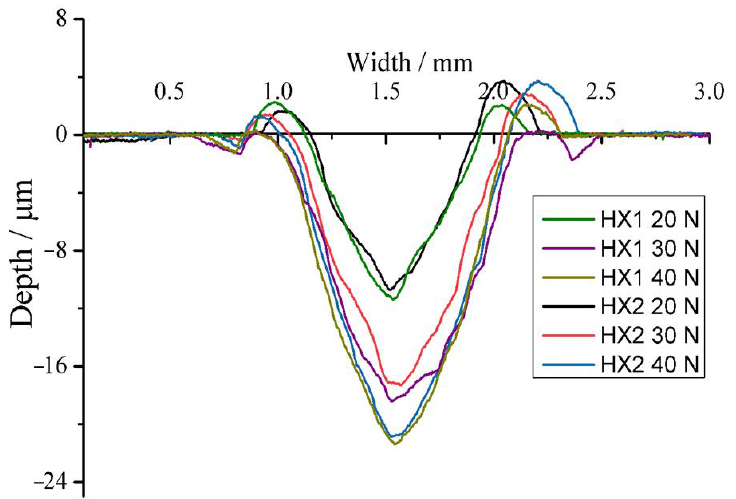
Figure 9. Two-dimensional (2D) profiles of the cross-section of the wear scars under different loads.